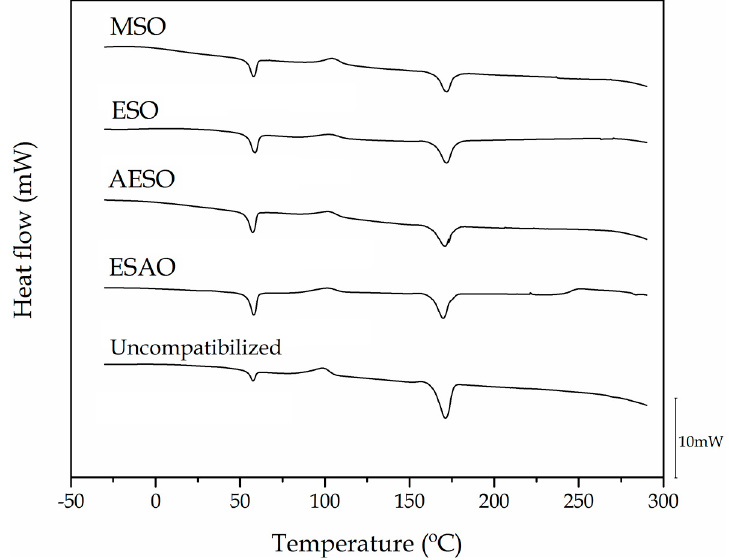
Figure 3. Comparative differential scanning calorimetry (DSC) thermograms (2nd heating) of PLA 60 /PHB 10 /PCL 30 blend with different compatibilizers.